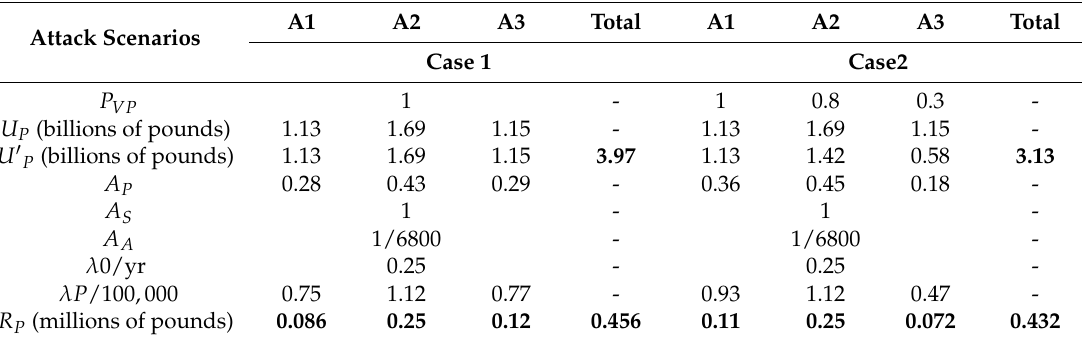
Table 7. Relative attractiveness and total annual